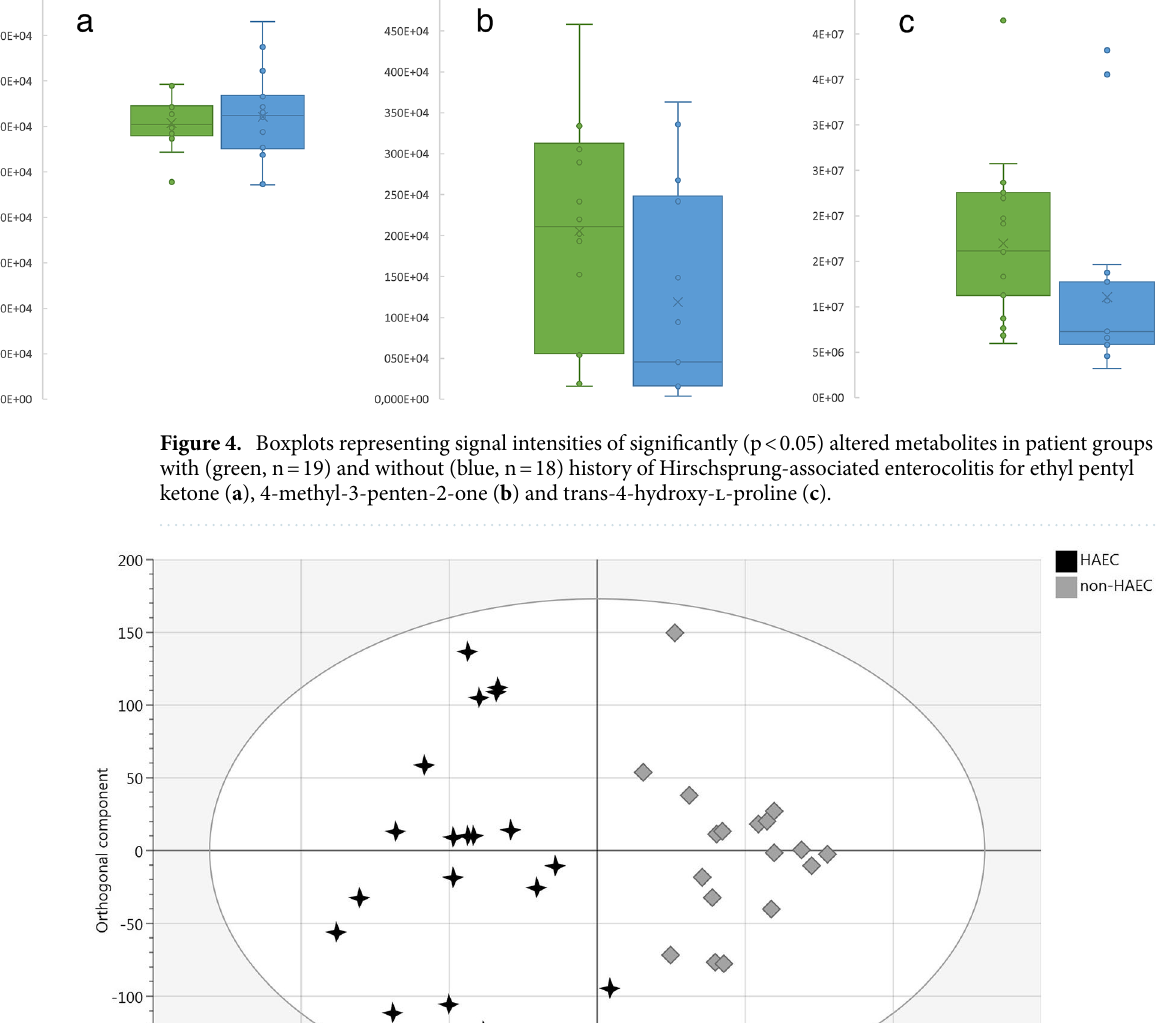
Table S4), revealing several dipeptides consisting of phenylalanine as common amino acid: i.e. glutaminylphe- nylalanine, phenylalanylvaline; as well as 6-hydroxymelatonin and 1-methylnicotinamide. Pathway analysis. Pathway analysis was based on 1782 features with a CV-ANOVA p-value < 0.05. Among the affected pathways, a significant difference between patients based on their HAEC history was revealed for tyrosine metabolism (p = 0.0028).